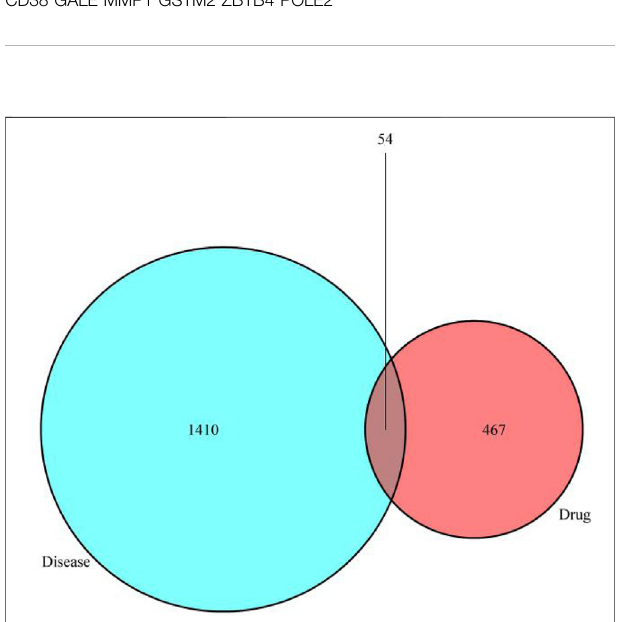
FIGURE 2 | Venn diagram: The 54 overlapping genes between trastuzumab and breast cancer.